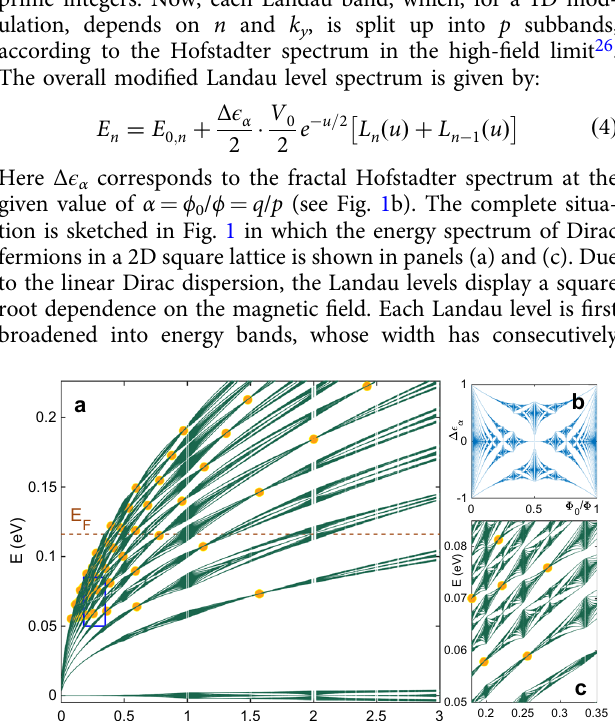
ffiffiffiffiffiffiffiffiffiffiffiffiffi p _ = ð eB Þ Fig. 1 Energy spectra of graphene subject to a 2D modulation. a Modi fi ed Landau level spectrum in 2D modulated graphene with a = 40 nm and V = 12 meV. Landau bands exhibit an internal structure given by the 0 Hofstadter butter fl y energy spectrum. Here, only Landau bands with n ≥ 0 up to n = 11 are shown; Landau levels with n < 0 can be obtained by re fl ection at E = 0. At unit fractions of the magnetic fl ux quantum ϕ 0 per superlattice unit cell the spectrum exhibits extended minibands across the full Landau band width giving rise to an enhanced band conductivity contribution analogous to the case of a 1D modulation. The circles mark the fl at band positions at which the usual Landau levels are restored. b Hofstadter energy spectrum in the high- fi eld limit, where the inverse fl ux is the relevant quantity. c Zoom into the blue box region of a , circles mark the fl at band